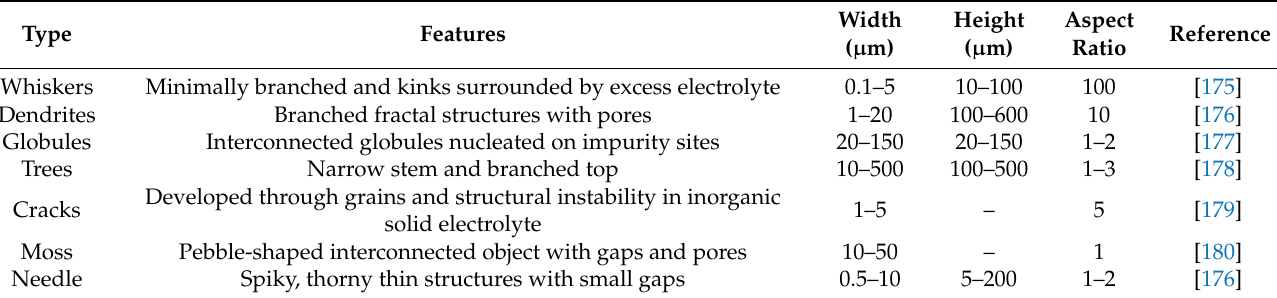
Figure 14. Different types of protrusions affecting battery performance: ( a ) whiskers (adapted with permission from [175]. J. Power Sources, Elsevier, 2011) ( b ) dendrites (adapted with permission from [176]. Acta Mater. 2017) ( c ) globules (adapted with permission from [177]. J. phys. Chem. C, 2018) ( d ) trees (adapted with permission from [178]. J. Power Sources, Elsevier, 2001) ( e ) cracks (adapted with permission from [179]. Electrochim Acta, Elsevier, 2017) ( f ) mosses (adapted with permission from [180]. Nat Commun, 2015). Table 3. Types of protrusions in metal